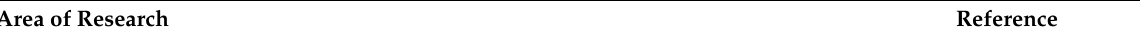
Table 1. STPA in vehicle/automotive safety and STAMP applications to road